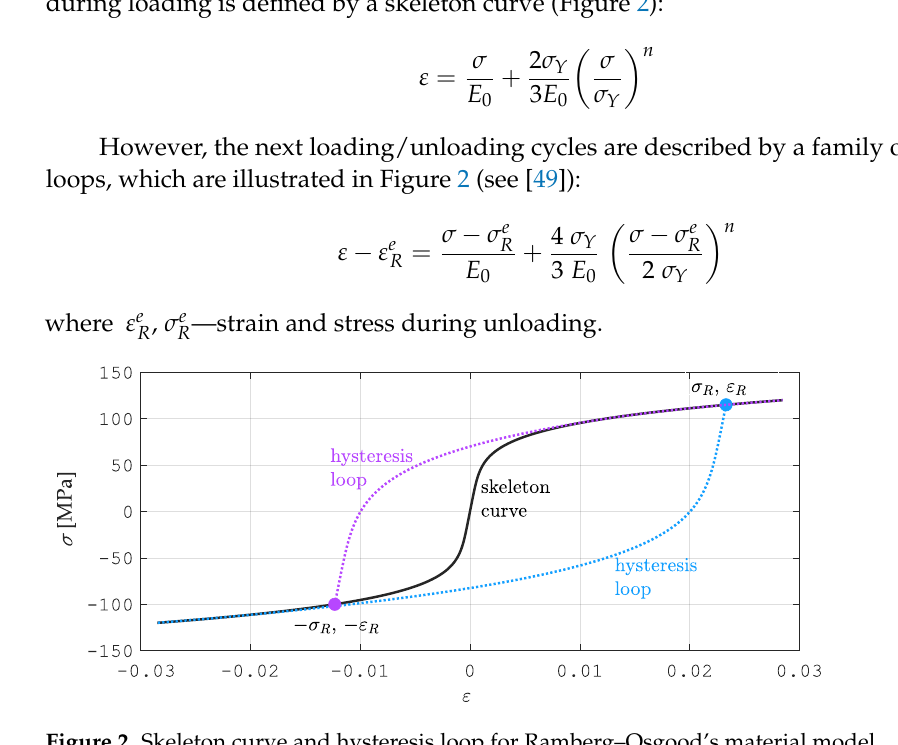
Figure 2. Skeleton curve and hysteresis loop for Ramberg–Osgood’s material model. The skeleton curve is marked in black in Figure 2—it carries out the first cycle of loading in the mechanical system. The blue color marks the branch of the loop that unloads the system in each cycle. The branch of the loop that unloads the system in cycles from the second to the final one, depending on the needs, is marked in